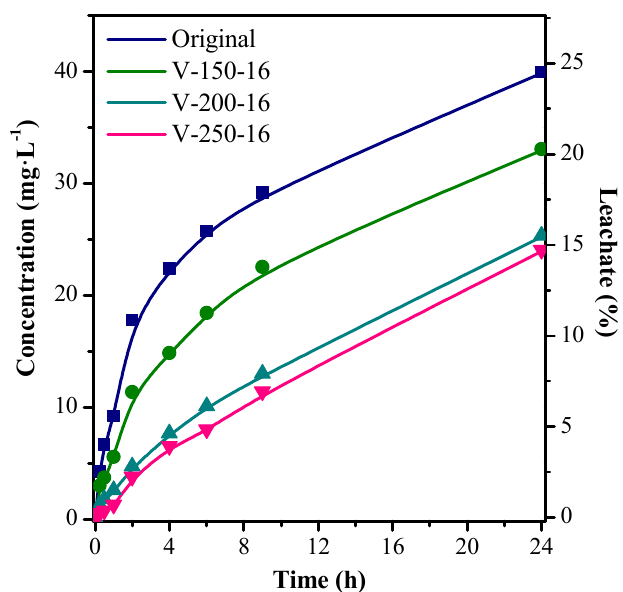
Figure 5. Linker leaching in water from NH 2 -MIL-125(Ti) before and after vacuum heat treated upon contact time.